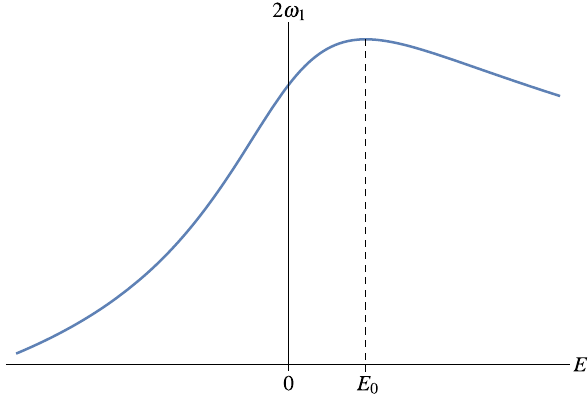
Fig. 1 Theperiodoftheellipticsolutionasafunctionoftheintegration constant